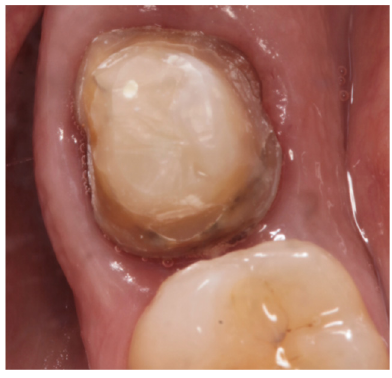
Figure 1. Abutment preparation.